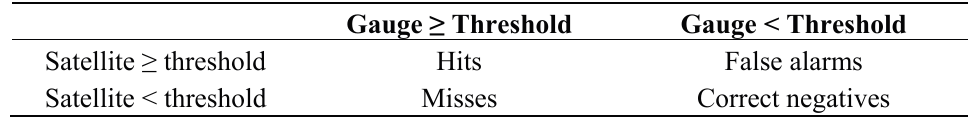
precipitation estimates. The rainfall threshold used is 1.0